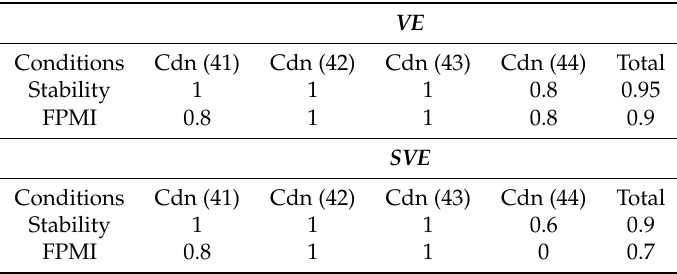
Table 3. Fraction of Correct Distance Conditions.